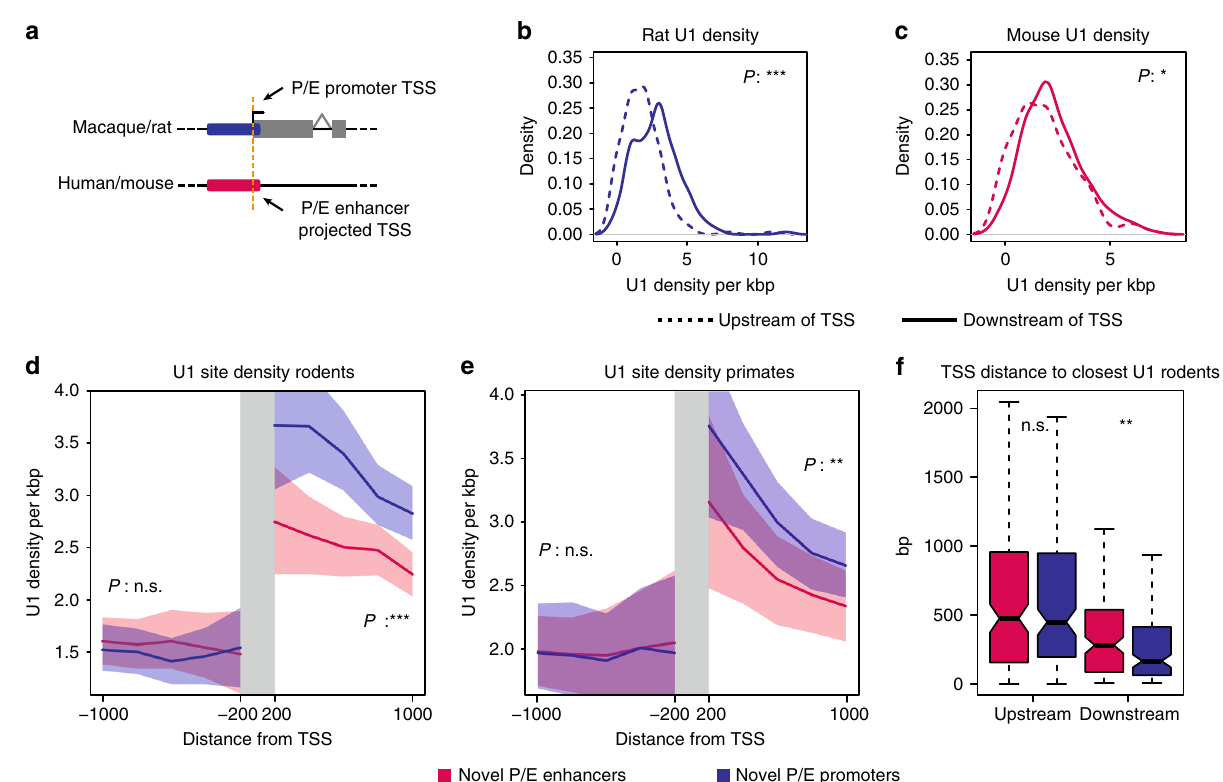
Fig. 4 U1 site distribution at P/E elements. a Schematic representation of an orthologous P/E element. The orange line depicts the position of the TSS in rat and of the projected location in mouse. b , c Distribution of U1 site density per kb upstream (dashed line) and downstream (continuous line) of the TSS of transcripts associated to novel P/E elements in rat b and mouse c . Signi fi cant differences (Mann – Whitney U -test with Benjamini-Hochberg correction): ∗∗∗ P < 0.001; ∗ P < 0.05. d , e Cumulative density of U1 sites up- and downstream of novel P/E-associated TSSs in rodents and primates, respectively. Lines represent the mean U1 density (per kb) over 200, 400, 600, 800, and 1000 nt-long windows from the TSS, shaded areas represent 95% con fi dence intervals. Signi fi cant differences (Mann – Whitney U -test with Benjamini-Hochberg correction): ∗∗∗ P < 0.001; ∗∗ P < 0.01; (n.s.) P ≥ 0.05. f Distribution of up- and downstream distances of the closest U1 site from each novel P/E-associated TSS in rodents. Whiskers up to 1.5 times the interquartile range; outliers removed for graphical purposes. Signi fi cant differences (one-tailed Mann – Whitney U -test with Benjamini-Hochberg correction): ∗∗ P < 0.01; (n.s.) P ≥